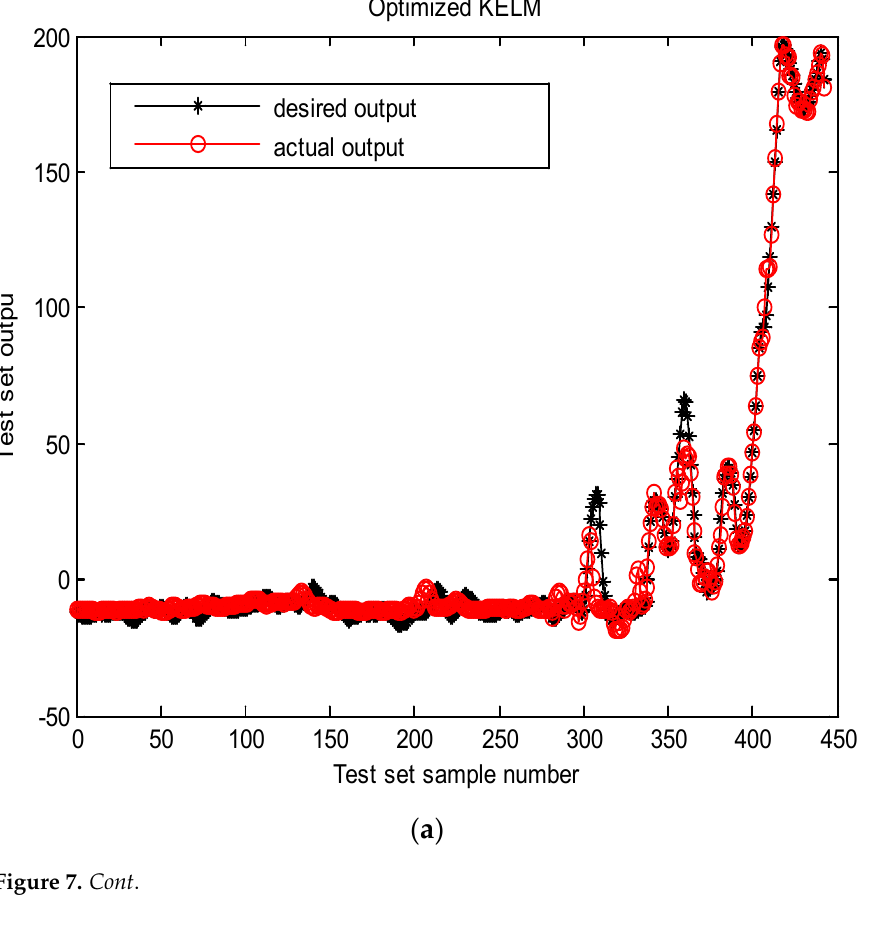
Table 3. Selected experimental datasets in different working conditions.